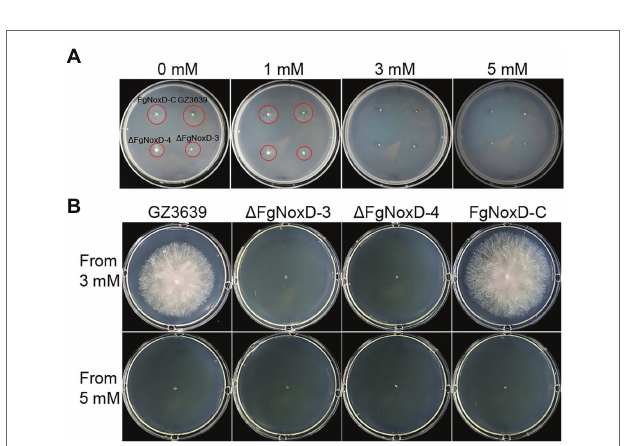
FIGURE 5 | Resistance of GZ3639, Δ FgNoxD, and FgNoxD-C to menadione. Fusarium graminearum strain was cultured on MM supplemented with different concentration of menadione for 3 days at 25 ° C. This experiment was repeated five times.